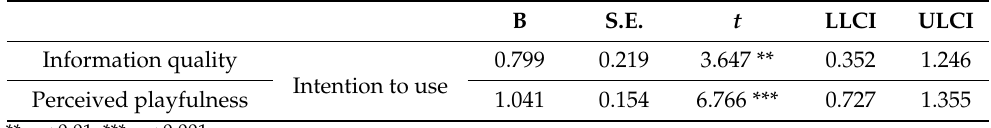
Table 4. Results of the mediation analyses of the indirect effects of two mediating variables. Perceived diversity → Information quality → Intention to use Perceived diversity → Perceived playfulness → Intention to